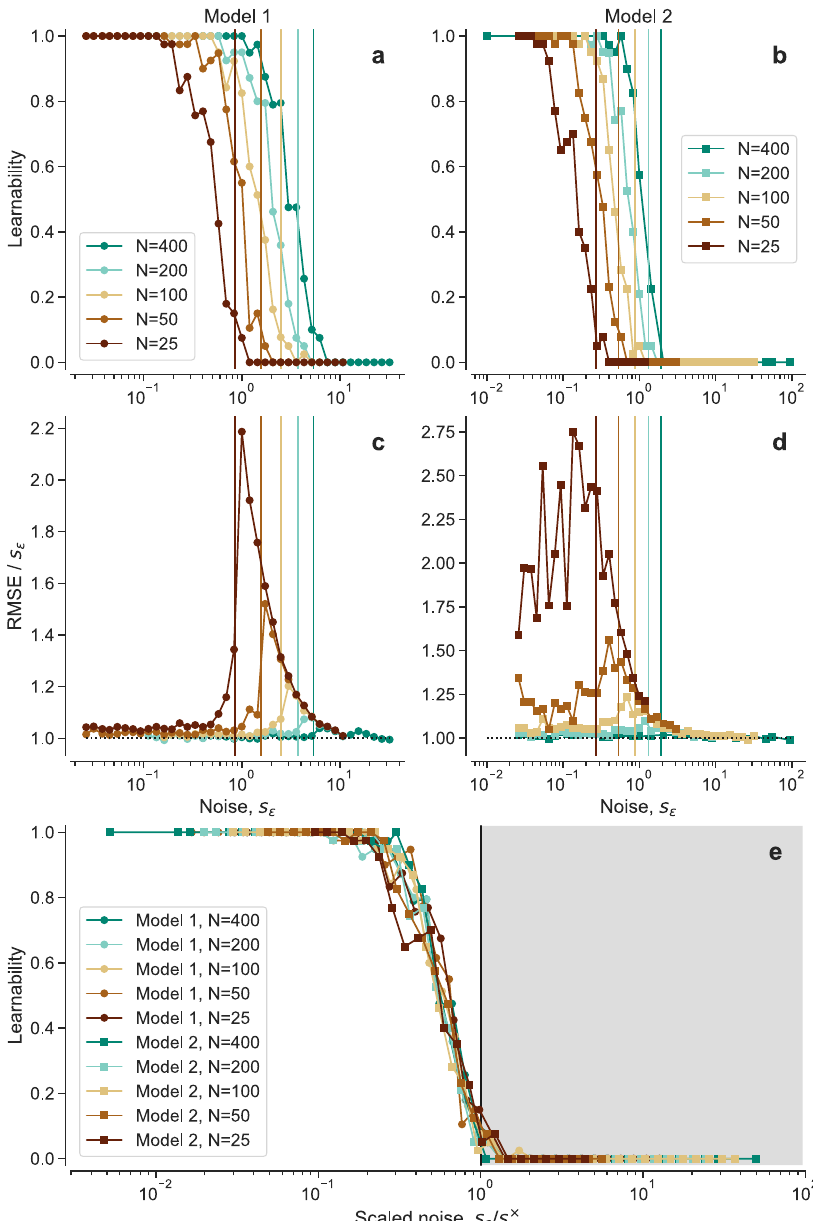
Fig. 3 | Learnability transition and scaling. a , b For each of the two models in Fig.1,werepresentthelearnability ρ ( s ϵ ),thatis,thefractionofdatasets D forwhich thetruemodel m * isthemostplausibleone,andthuscanbelearnedfromthedata. Verticallinesareestimatesofthelearnabilitytransitionpoint s × ϵ fromEq.(8). c , d As inFig.1e,f,werepresentthescaledpredictionrootmeansquarederror(RMSE)for